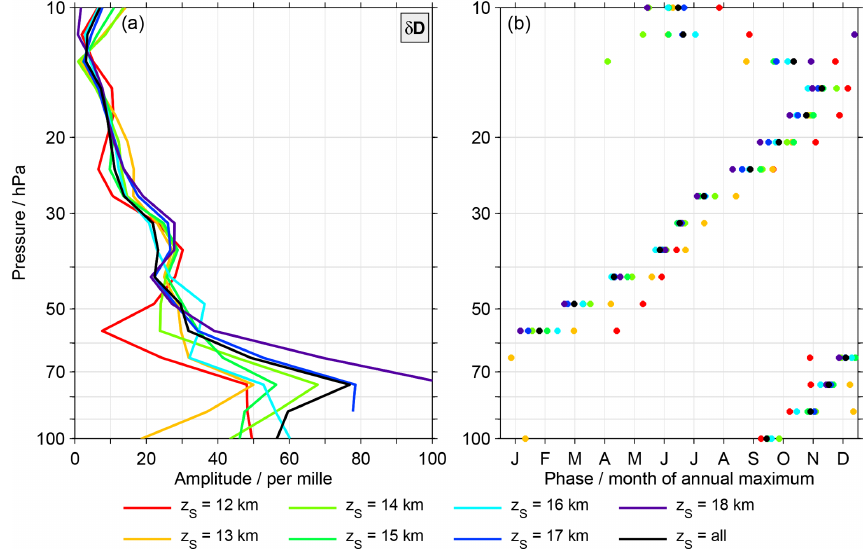
Figure 9. Characteristics of the δ D annual variation for MIPAS data with specific start altitudes. Panel (a) shows the amplitudes while in panel (b) phase estimates are shown. For the sake of simplicity, no error bars are provided, unlike in Figs. 3 and 4.